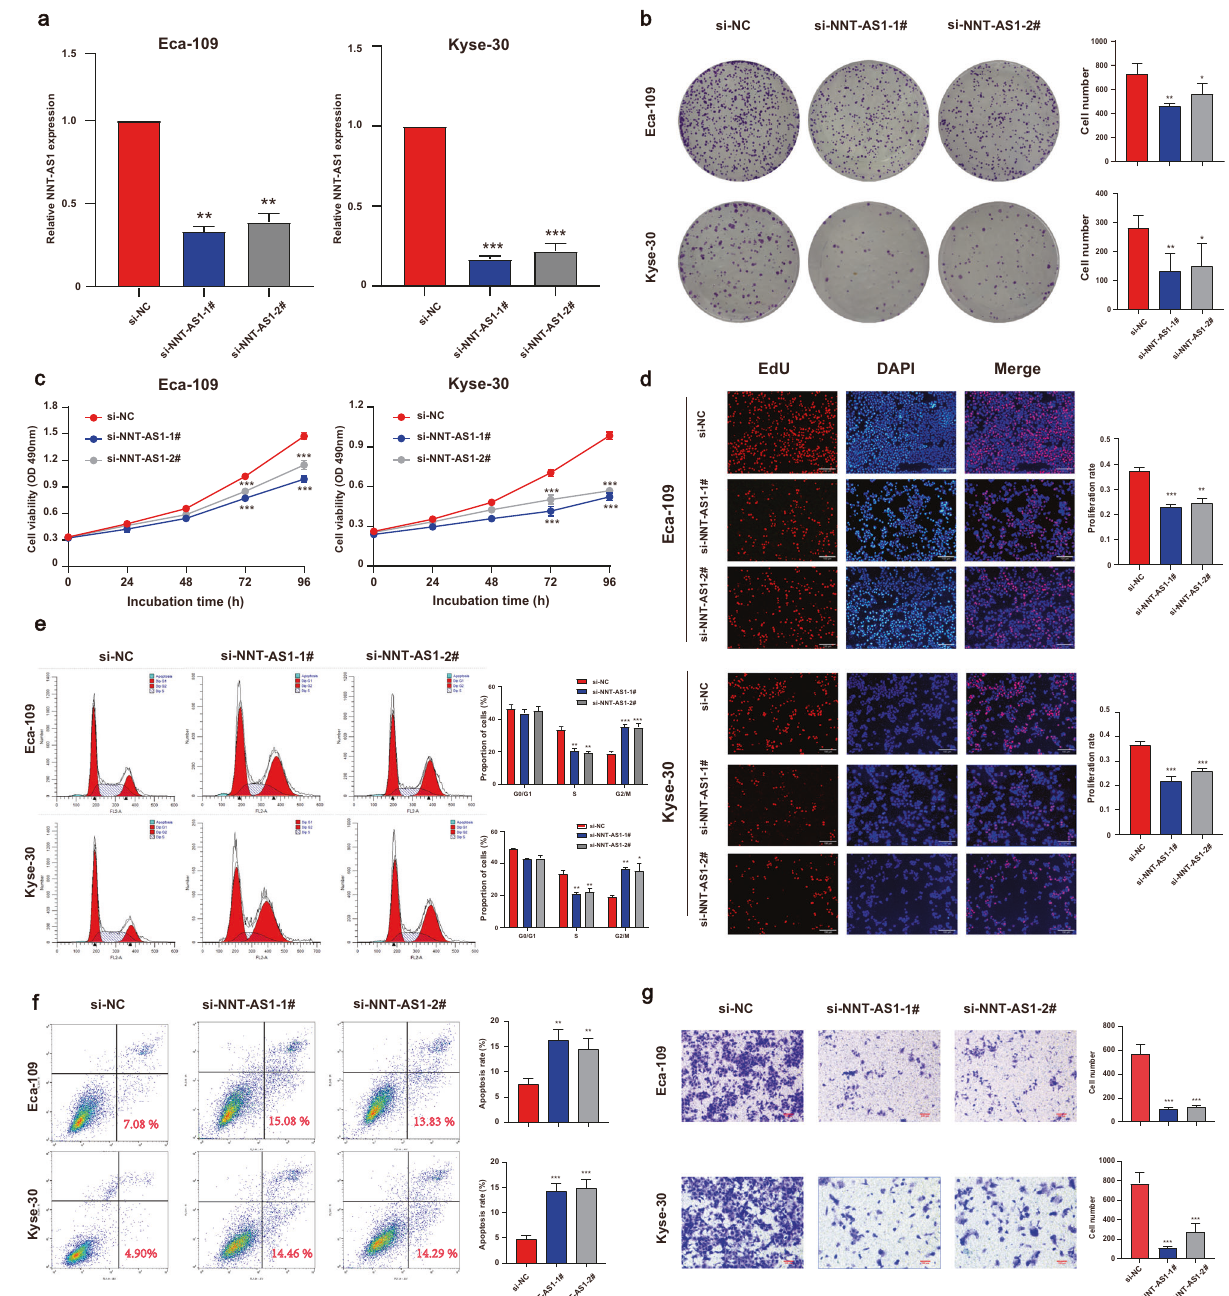
Fig. 2 Knockdown of NNT-AS1 inhibited ESCC cell proliferation, migration, and induced cell cycle arrest, and promoted cell apoptosis. a The knockdown ef fi ciency of short interfering RNAs for NNT-AS1; b – d knockdown of NNT-AS1 signi fi cantly inhibited the proliferation of Eca- 109 and Kyse-30 cells using colony forming assays ( b ), MTT assays ( c ), and EdU assays ( d ); e cell cycle assays were employed to detect the distribution of cells in different phases; f knockdown of NNT-AS1 increased the apoptotic rate of both cell lines; g knockdown of NNT-AS1 inhibited the migration of Eca-109 and Kyse-30 cells. The results were from three independent experiments. Data were analyzed by unpaired Student ’ s t -test. *** P < 0.001, ** P < 0.01, * P < 0.05. Variables were presented as the Mean ± SD. growth and migration of ESCC cells, while NNT overexpression membrane. Previous studies showed that NNT served as an partially retrieved the decreased proliferation and migration oncogene in multiple cancers. For example, knockdown of NNT abilities induced by NNT-AS1 inhibition. Highlighting these signi fi cantly suppressed gastric cancer growth and metastasis fi ndings, we speculated that NNT-AS1 could modulate ESCC through the oxidative stress pathway [26]. NNT could regulate tumorigenesis and progression by regulating its sense gene NNT. mitochondrial metabolism in lung cancer by maintaining the Given that ceRNA was a common mechanism through which function of the Fe-S protein [27]. Nevertheless, the roles of NNT in lncRNAs regulated the target genes [28, 29], we predicted the ESCC progression have not been revealed. In this study, we potential miRNAs that could interact with NNT-AS1. Consequently, observed that the silence of NNT exerted inhibitory effects on the Cell Death Discovery (2022)